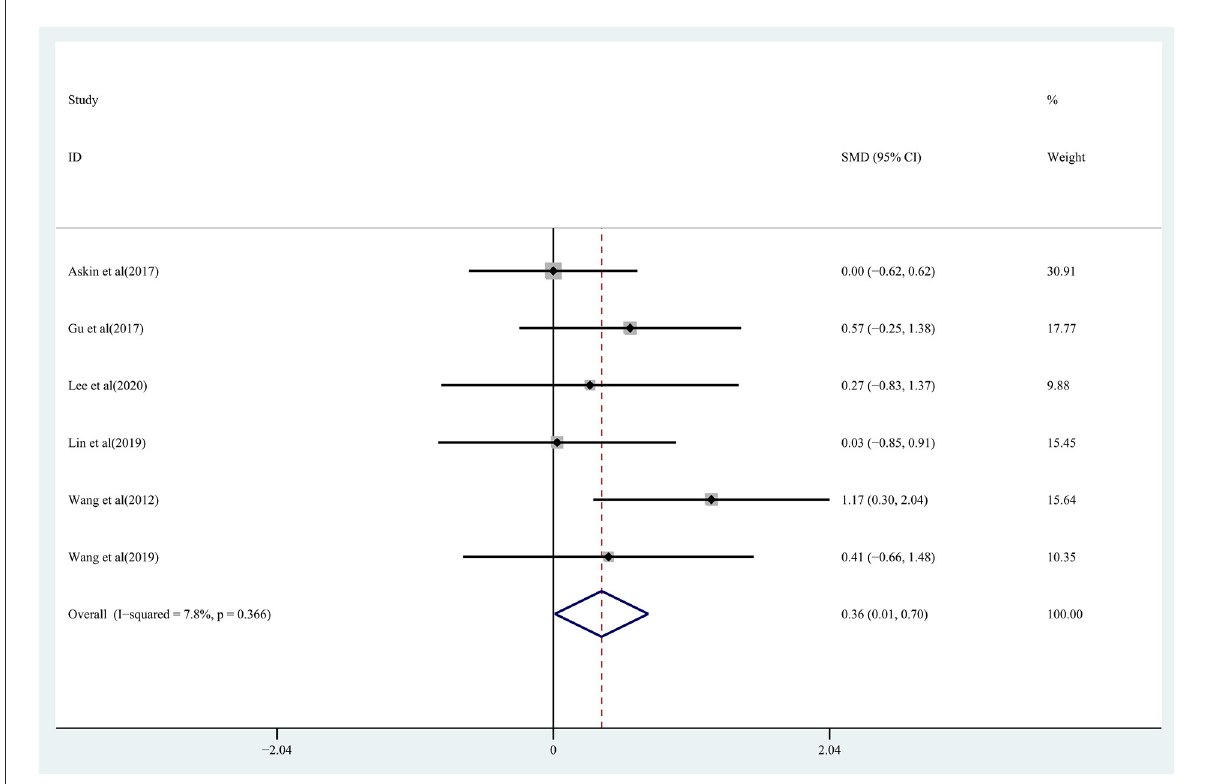
FIGURE8 Forest plot of the effect of rTMS treatment on walking function recovery in chronic stroke